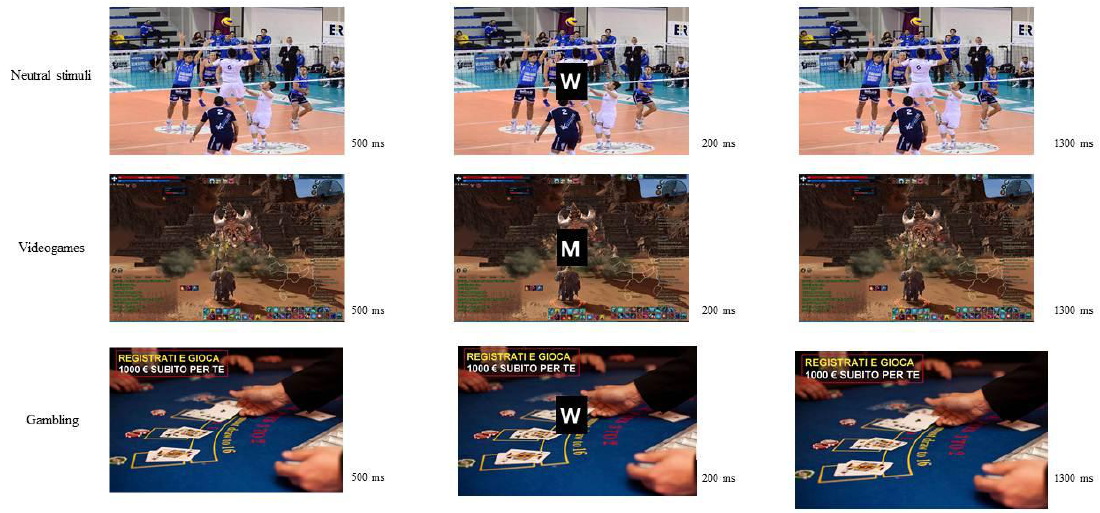
Figure 1. Experimental task. Each trial consisted of the presentation of a background picture (neutral, gambling and videogames) for 500 ms then the letter M or W appeared in the center of this picture for 200